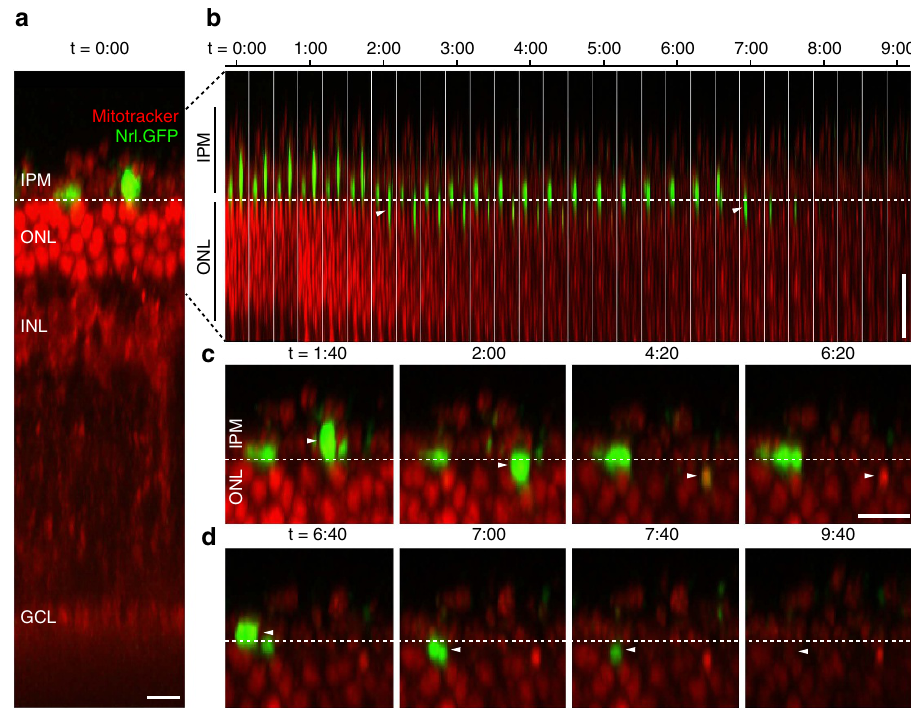
Figure 1 | Real-time imaging of transplanted donor precursor cells migrating into host retinae. NrlGFP post-mitotic photoreceptor precursor donor cells ( green ) were transplanted into 12 weeks old Prph2 rd2/rd2 mice and explanted retinae were examined by real-time 2-photon fluorescence live imaging 3 days post transplantation (retinae, including donor and host cells, were acutely labelled with Mitotracker Orange CMTMRos ( red ) before the recording). ( a ), At the start of the time-lapse recordings, sub-retinally transplanted rod precursor cells were frequently observed at the level of the IPM or apical to the retinal tissue. A dashed line ( white ) was inserted at the presumptive level of the OLM. ( b ), Time course of rod precursor cell movement from the IPM into the ONL; penetration through the OLM ( white dashed line ) is indicated by white arrowheads (see also Supplementary Movie 1). ( c , d ), High magnification views of time frames shown in ( b ) depicting migration of the right ( c ) and left ( d ) rod precursor cell into the ONL at selected time points. Note that while GFP fluorescence gradually reduced over the imaging period, Mitotracker Orange CMTMRos labelling, which is present in both donor and host cells, persisted in its absence. Scale bars, 10 m